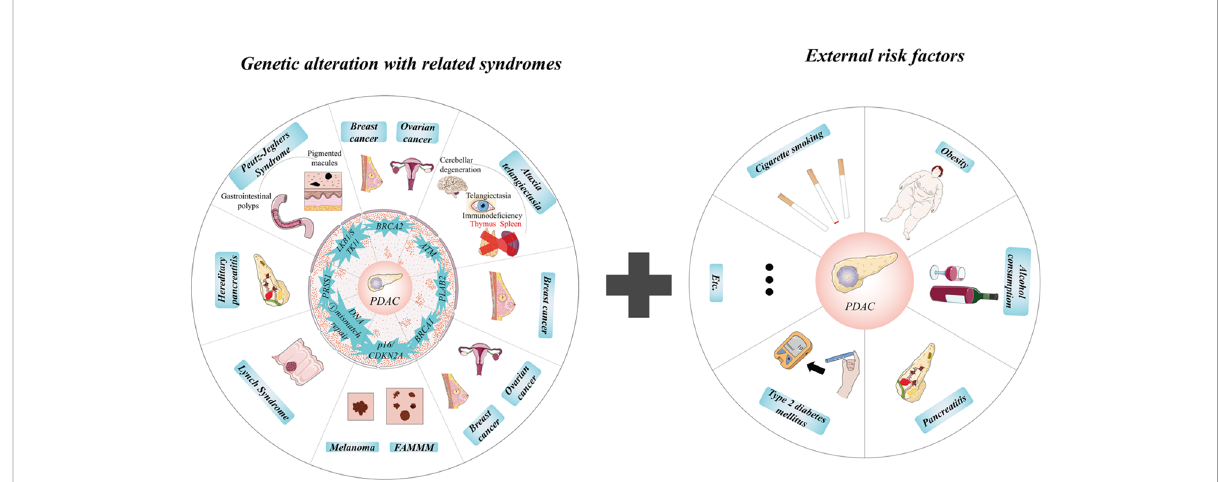
FIGURE 1 Internal and external risks of pancreatic ductal adenocarcinoma (PDAC). Notably, familial PDAC shows a remarkably rising risk of PDAC compared with the general population. Based on these altered genes and mutation-related syndromes, there is an excellent opportunity to quantify the risk of PDAC, which is essential for the clinical application of early detection and timely treatment of PDAC and screening for the risk of other malignant diseases. ① , DNA mismatch repair genes include hMSH2, hMLH1, hPMS1, hPMS2, and